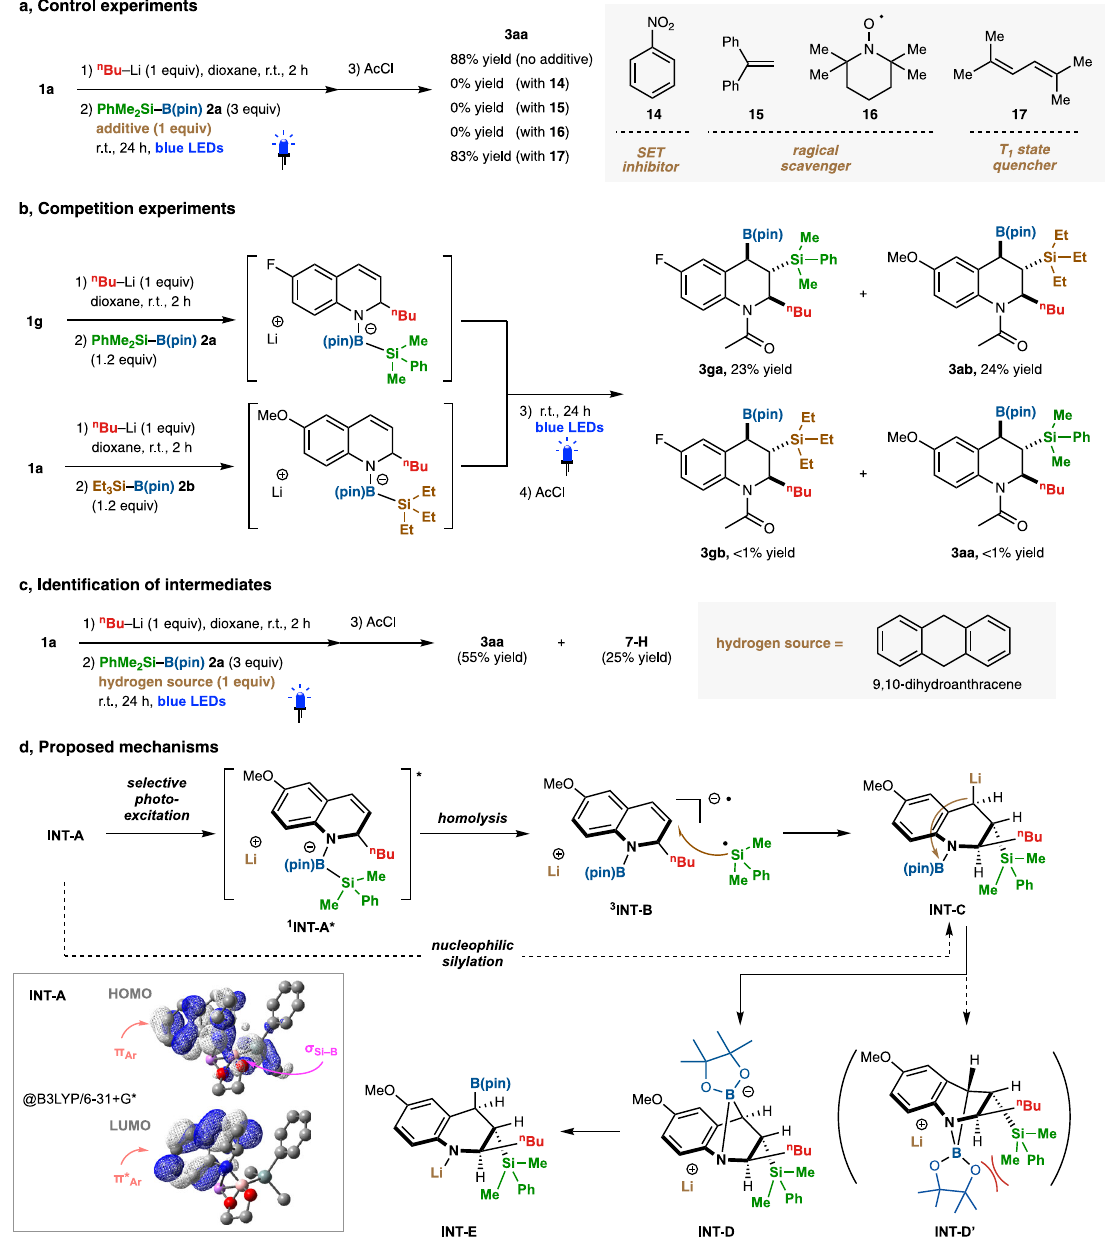
Fig. 5 | Experimental mechanistic studies. a Control experiments. b Competition experiments. c Identi fi cation of intermediates. d Proposed mechanisms. Yields were determined by 1 H-NMR